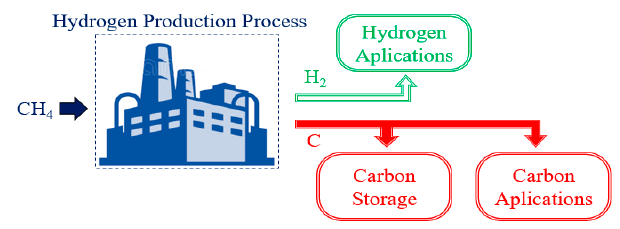
Figure 4. Hydrogen production process by methane cracking.